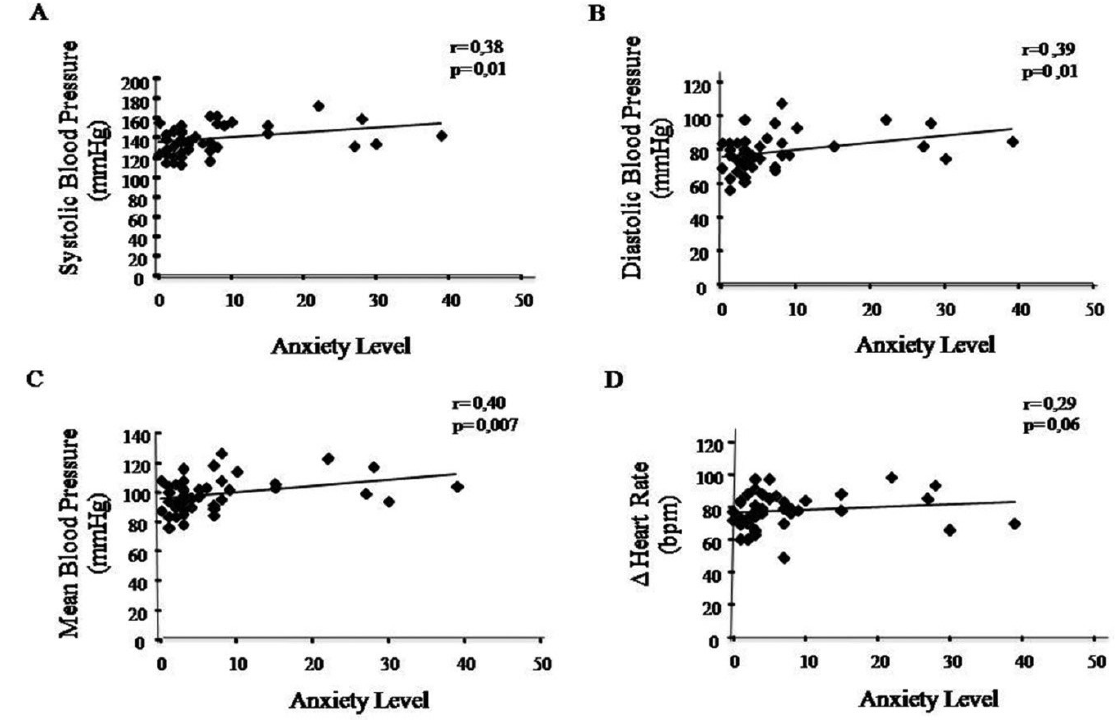
Figure 6. Relationships between anxiety level and systolic, diastolic, and mean blood pressure and heart rate levels (panels A, B, C, and D, respectively) during the handgrip exercise protocol at 30% of maximal voluntary contraction. Note that the anxiety level showed directly proportional correlations with systolic, diastolic, and mean blood pressure levels. We did not observe a correlation between anxiety level and heart